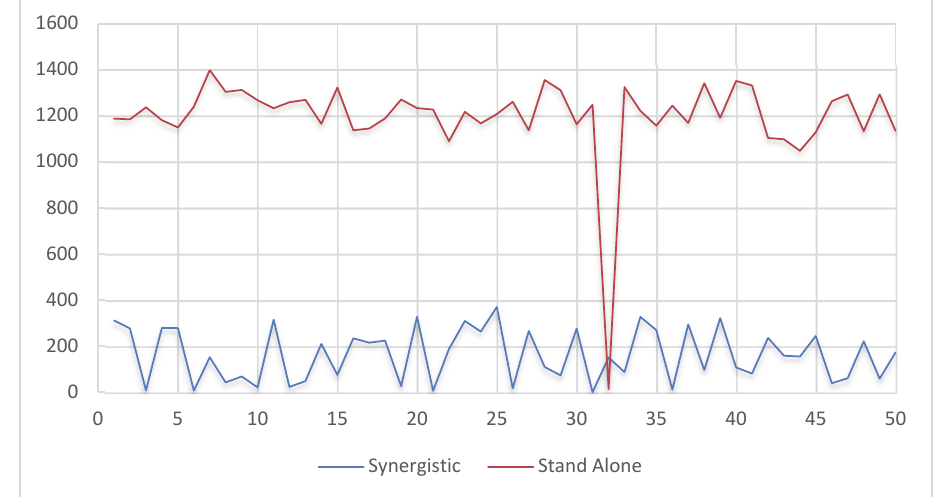
Fig. 10. Chart of the residual portfolio budget in two different cases